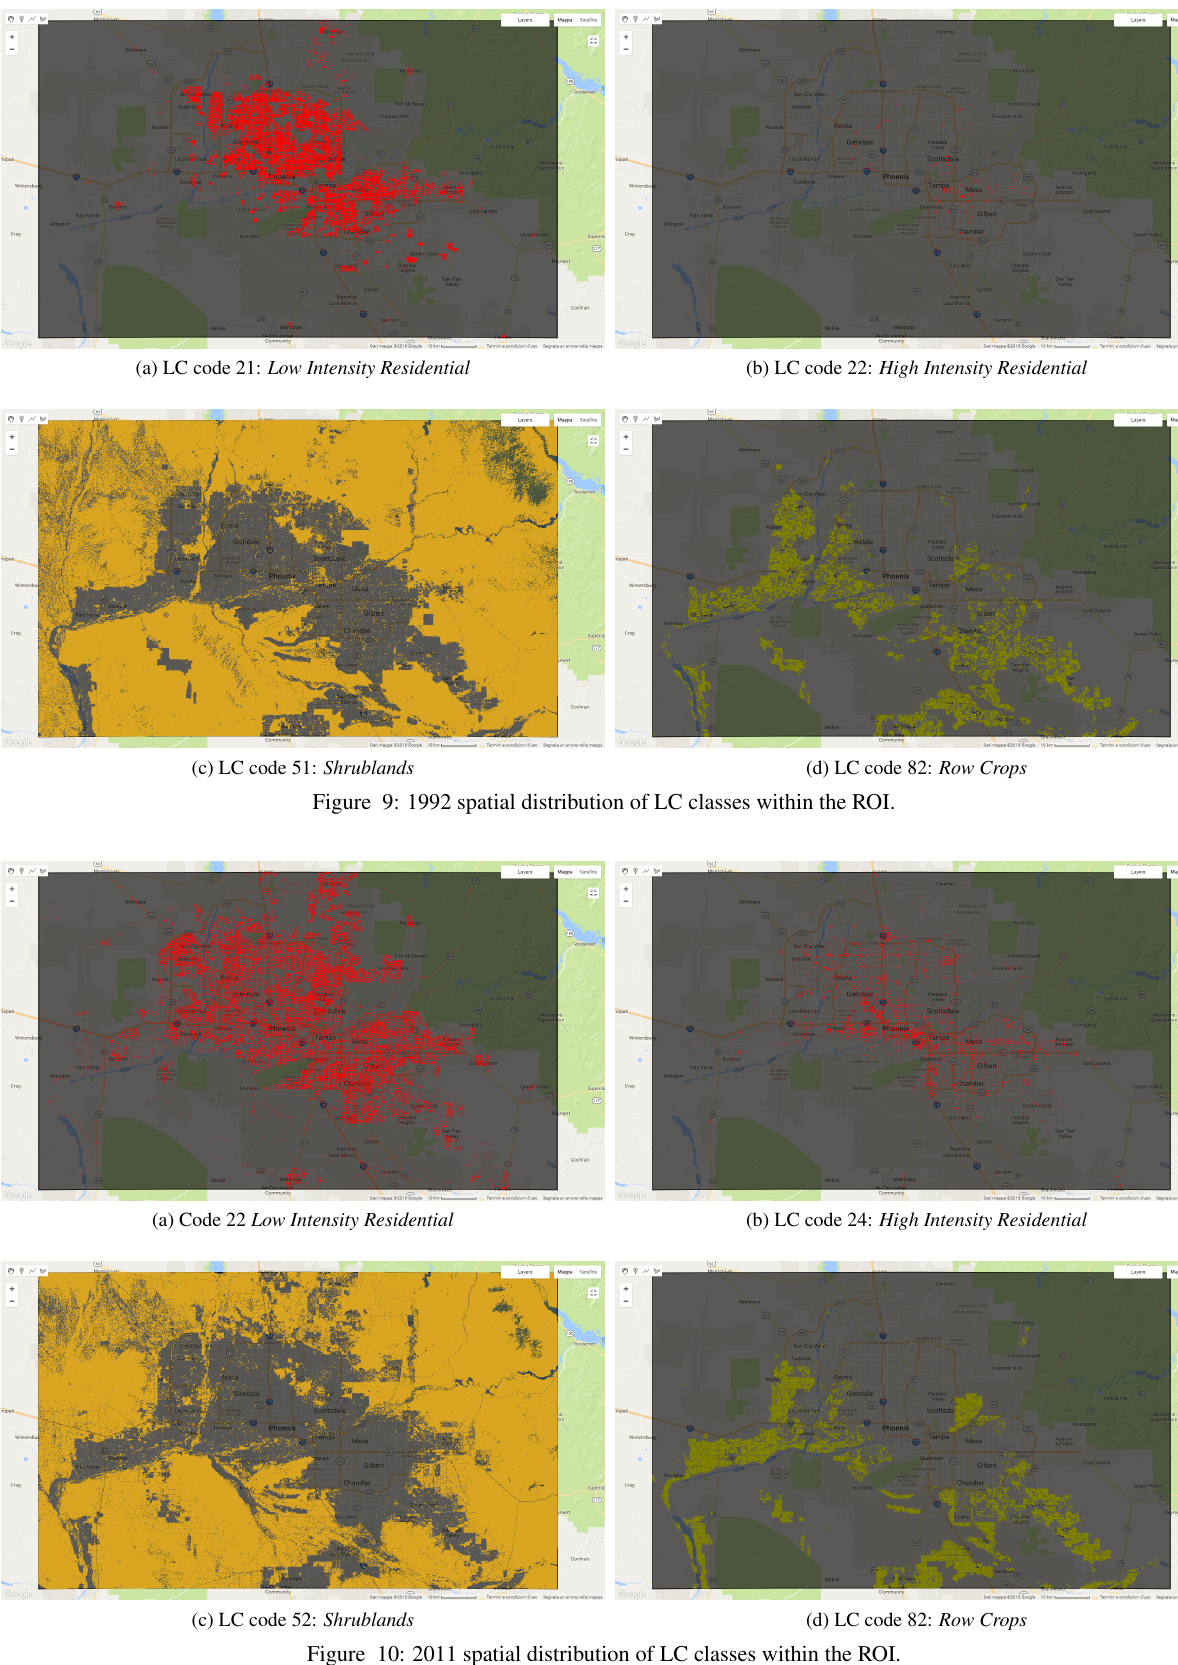
Figure 10: 2011 spatial distribution of LC classes within the